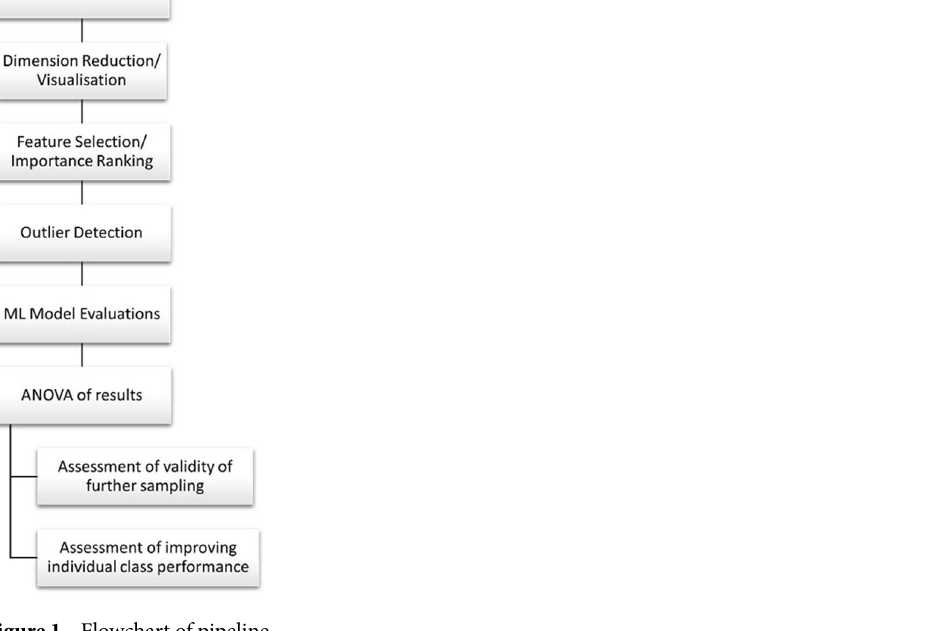
Figure 1. Flowchart of